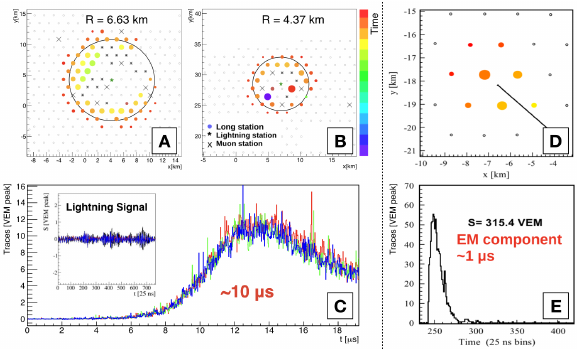
Figure 4. The comparison between the signal of the anomalous events (panels A, B and C in the left column) and the signal of cosmic-ray showers (panels D and E in the right column) in the SD. The large footprint and the longer traces of the atmospheric events are the distinguishable features. Panels A and B: two dif- ferent events recorded by the SD, which are known to be corre- lated with lightning. Each dot represents an SD station, with the time of the peak shown as the color and the intensity portrayed by the size of individual disks. A simple circular fit is performed to estimate the size of the event. The reader should note the addi- tional presence of stations triggered by lightning. Panel C: exam- ple traces of the three PMTs in a station that represent the signal of an anomalous event. The smaller plot is there to provide a contrast of those traces with lightning-triggered stations. Panel D: the typical footprint of a cosmic-ray shower detected towards the center of the SD. The meaning behind the size and color of the marker is the same as for the anomalous events. The black line represents the reconstructed arrival direction of the cosmic ray, projected onto the ground. Panel E: a typical trace in an SD station for a cosmic-ray event, dominated by time propagation of the electromagnetic component of the